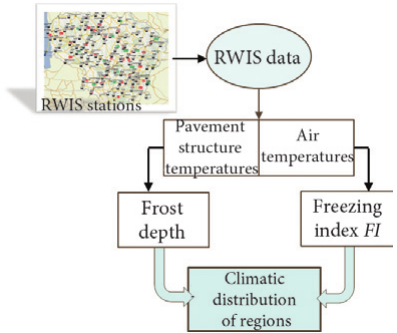
Fig. 5. The steps of frost depth calculation using the complete model